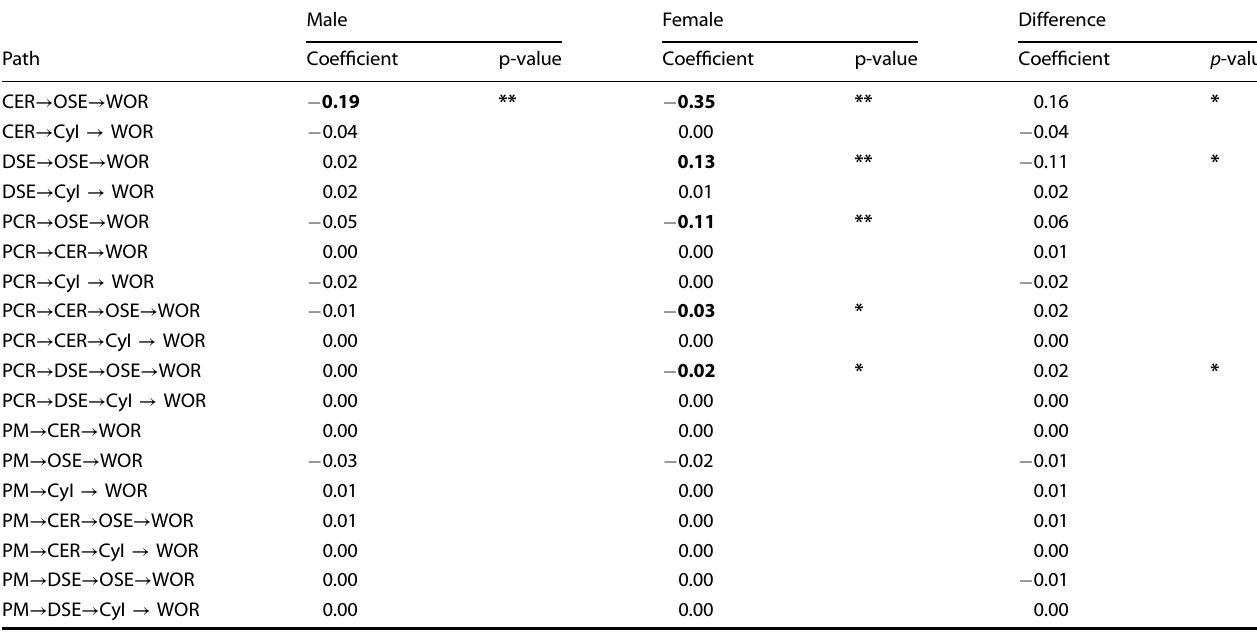
Table 2. Results of indirect effects and group